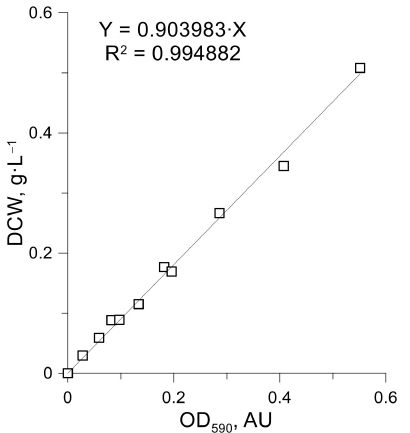
Figure A1. Calibration curve of OD 590 vs. DCW for micro-cultivation experiments.